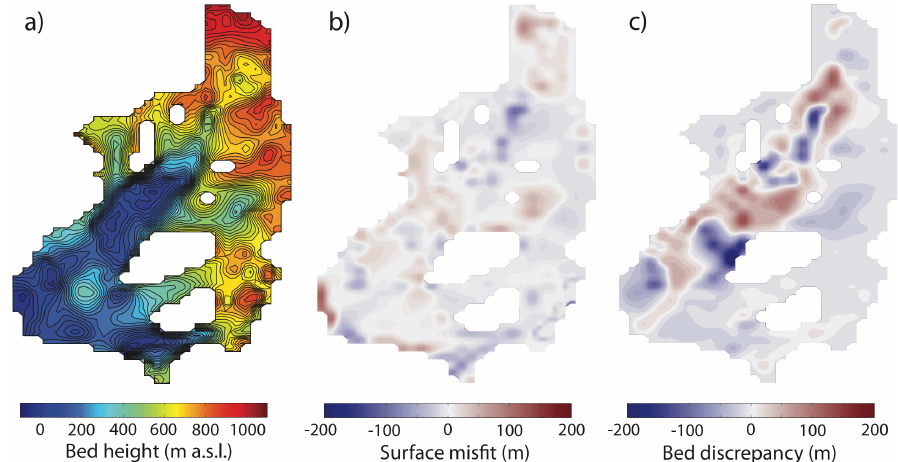
Fig. 16. Reconstructed bed with bed heights fixed when radar observations are available in panel (a) . The corresponding remaining surface misfit is shown in panel (b) . Panel (c) shows the bed discrepancy with regard to the basal topography in the unconstrained experiment with φ = 13 ◦